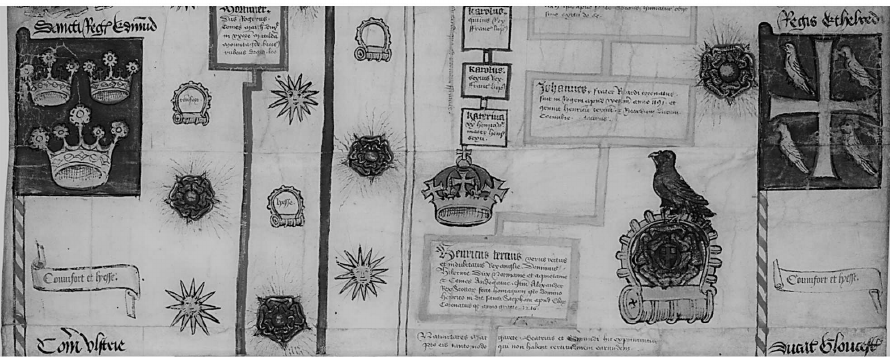
Figure 4. A fragment of FLP MS Lewis E 201 showing, among others, the alternat- ing suns, fetterlocks and roses, as well as the combined badges of the rose, fetterlock and falcon (public